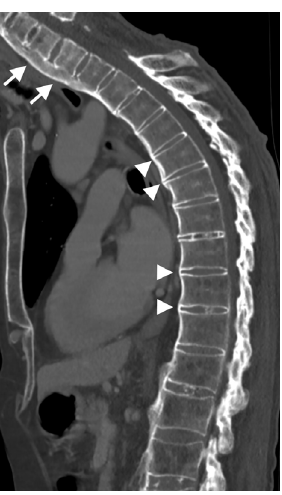
Table 1. DISH vs. Spondyloarthritis: differences and similarities.